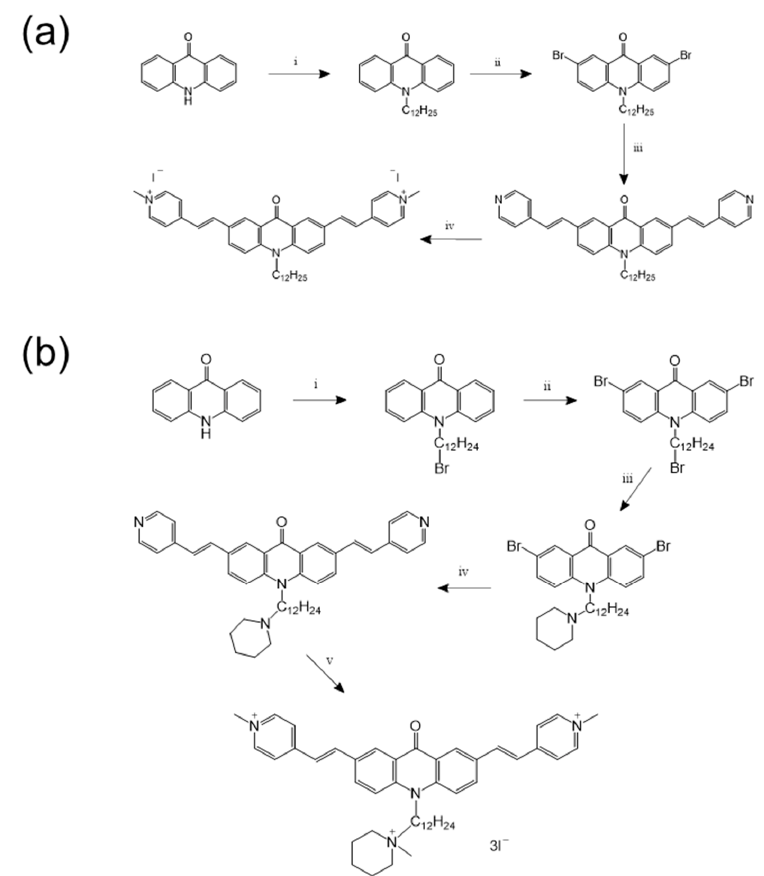
Figure 1. Schemes representing synthesis procedures and the corresponding yields from ( a ) MeAcd12C and ( b ) MeAcd12P conditions; ( a ) i, 1-bromododecane, KI, KOH, THF, 40 ◦ C, 62%; ii, NBS, DMF, 80 ◦ C, 83.7%; iii, 4-vinylpyridine, Pd(OAc)2, (o-tol)3P, MeCN, Et3N, N2, 80 ◦ C, 30%; iv, CH3I, DMF, Acetone, 80%. ( b ) i, 1,12-dibromododecane, KI, KOH, THF, 40oC, 54%; ii, NBS, MeCN, reflux, 97%; iii, piperidine, K2CO3, THF / H2O, reflux, 91.6%; iv, 4-vinylpyridine, Pd(OAc)2, (o-tol)3P, MeCN, Et3N, N2, 80 ◦ C, 63%; v, CH3I, DMF, Acetone,